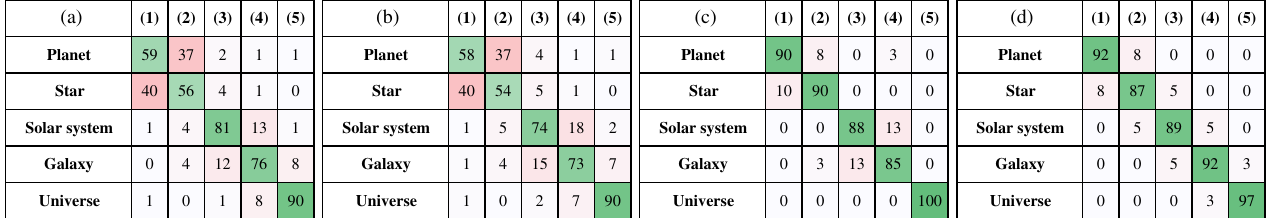
FIG. 2. Size ranks assigned to astronomical objects in Q5a, by middle school students (a) preinstruction and (b) postinstruction and preservice teachers (c) preinstruction and (d) postinstruction. Each matrix element indicates the percentage of respondents who assigned a specific rank (column number) to a specific item (row). The objects are ordered so that the diagonal corresponds to correct rankings, i.e., planet should be ranked first, star second, etc. The color scale is added simply to aid visual clarity, with the level of green saturation highlighting items most often ranked correctly, and the level of red saturation highlighting the most prevalent mistakes. For example, matrix (a) tells us only 59% of the preinstruction middle school students could identify a planet as the smallest item in the list, regardless of how they ranked other items, while 13% of them wrongly thought that a solar system (or the Solar System) was the second largest item in the list. The numbers of valid responses analyzed to produce each matrix, out of the total number of nonblank responses, were (a) 519 out of 522, i.e., 99%, (b) 372 out of 384, i.e., 97%, (c) 40 out of 40, i.e., 100%, and (d) 38 out of 38, i.e., 100%,